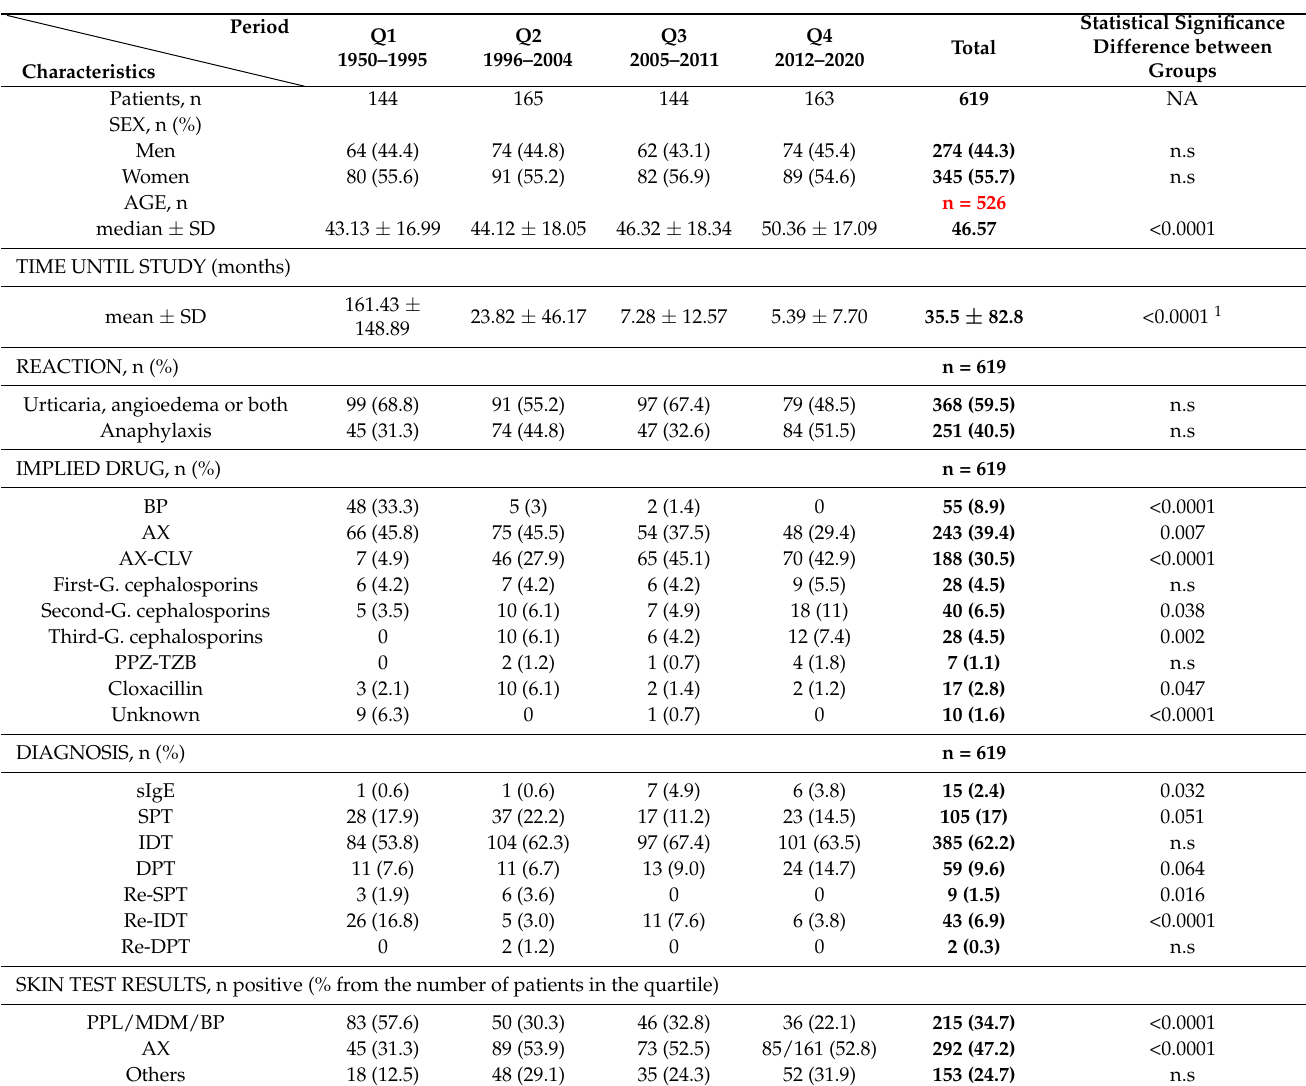
Table 1. Characteristics of the patients, drug involved, and results of diagnostic